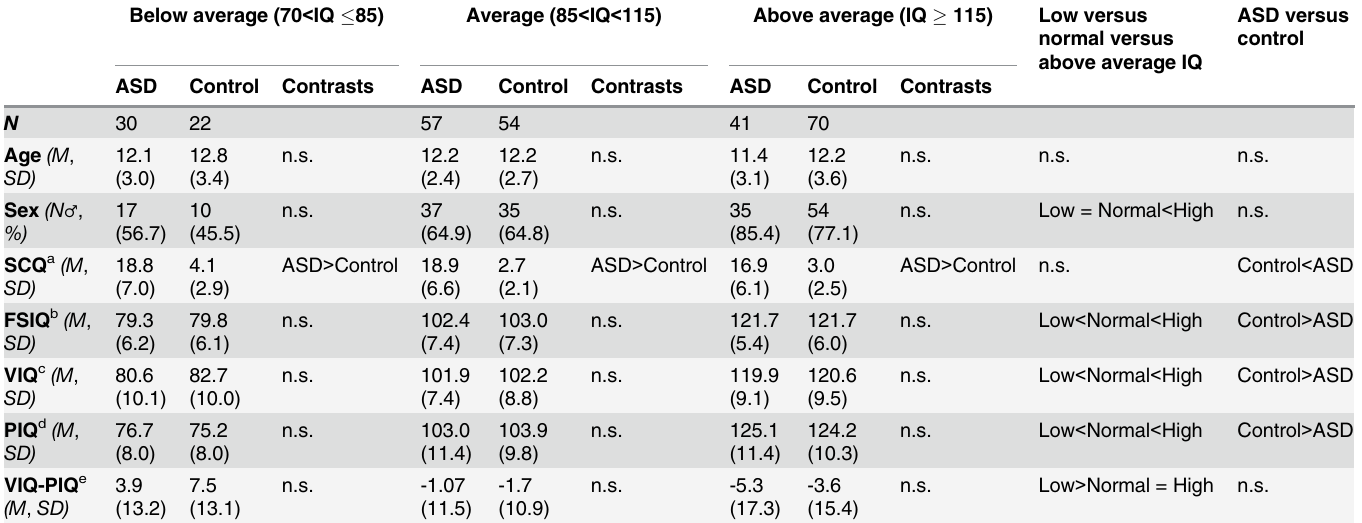
Table 1. Participant